Question: Briefly state, in one sentence, what is plotted here.
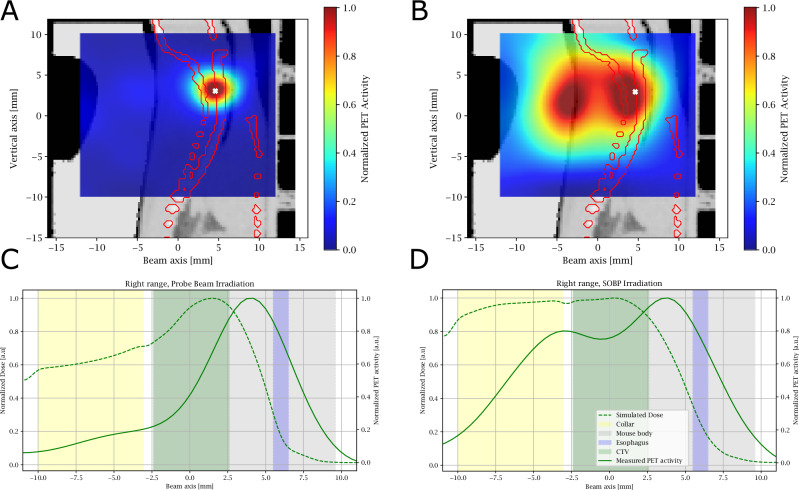
Answer: Irradiation in the “Right” position. A Online SIRMIO PET image of the positron activity distribution acquired during the 11 C-irradiation in the R (Goldilocks range) position with the collimated monoenergetic pristine beam overlaid on the SARRP scan of the mice under irradiation. B Online SIRMIO PET image acquired during the full SOBP irradiation with 20 Gy in the R position. Figure 1C shows the corresponding simulated dose distribution. C , D 1D profiles along the beam direction (z-axis) of the simulated dose (normalized to the target dose; dashed green) and the measured (solid green) PET activity profiles, normalized to their maximum and laterally integrated on the BEV aperture (±1 mm x, 2–3 mm y) for the monoenergetic and SOBP configuration, respectively. The CTV, esophagus and mouse body are highlighted by green, blue and gray bands, respectively, while the compensator is depicted in yellow. The white “×” marker indicates the position along the beam axis corresponding to the 80% fall-off of the collimated 11 C pure beam distribution.